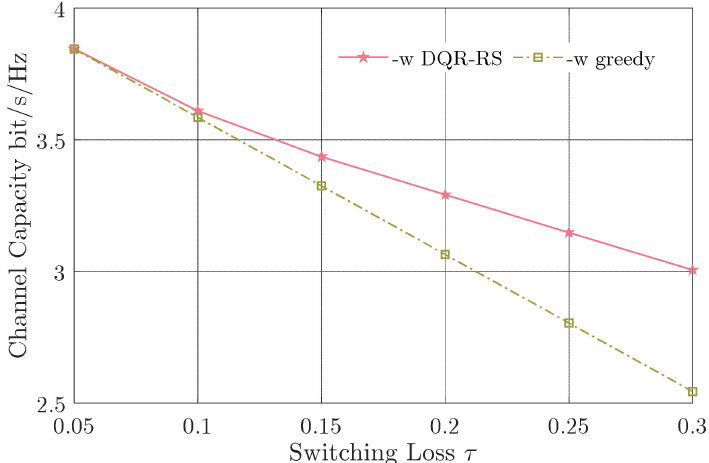
Figure 6. Channel capacity versus switching loss τ